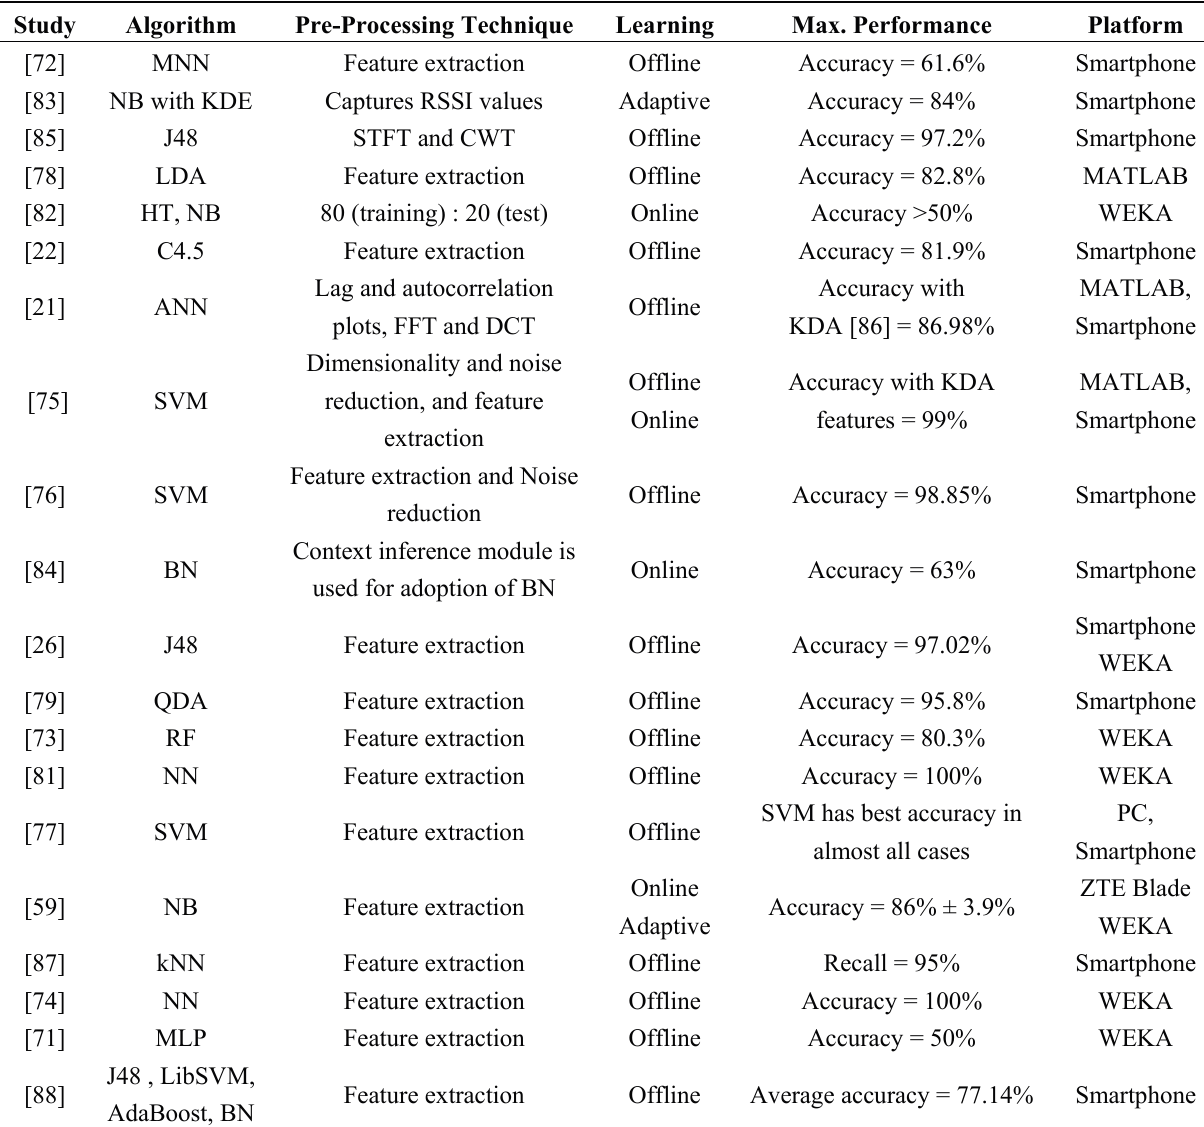
Table 4. Classification algorithms in